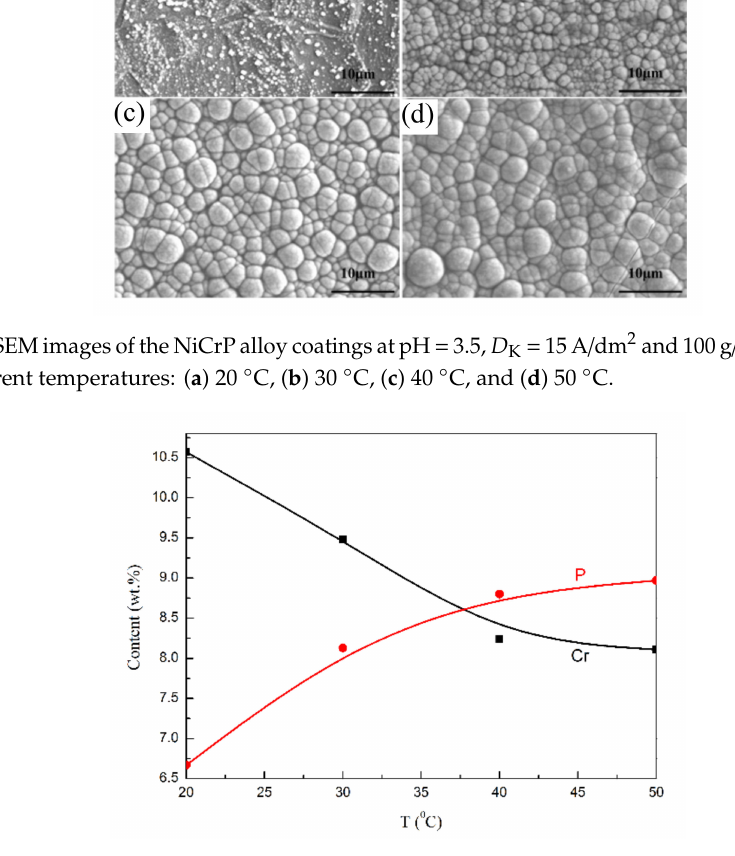
Figure 4. Relationship between the temperature and composition of the alloy